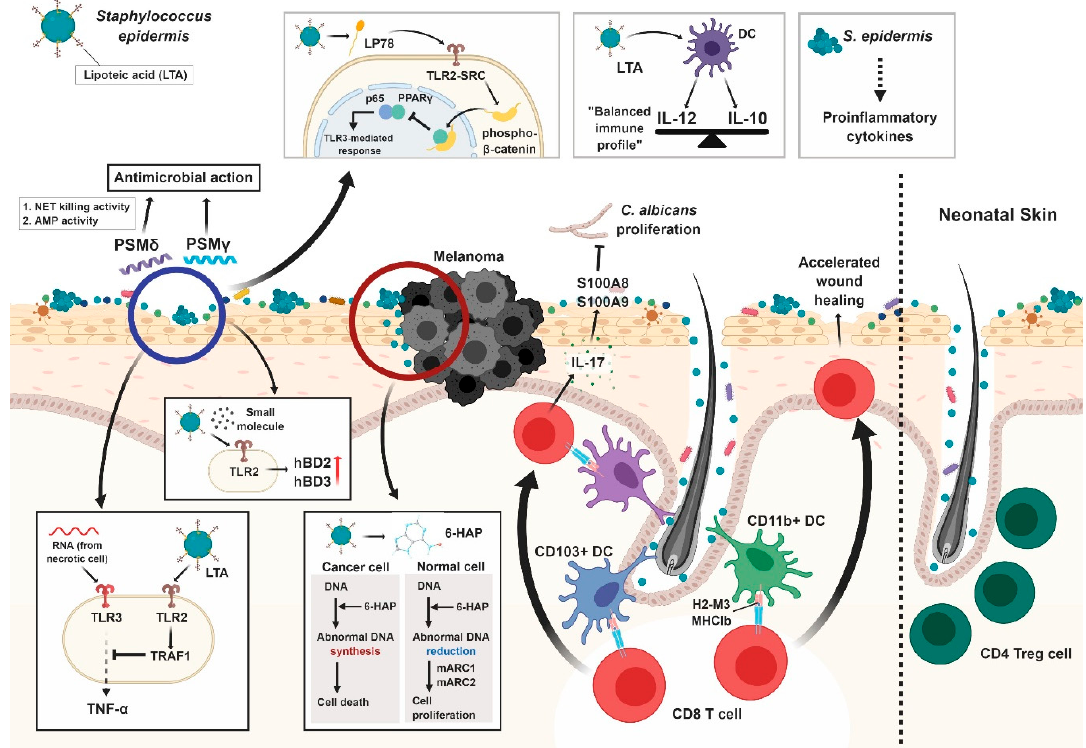
Figure 2. Interaction between Staphylococcus epidermis and skin immune system. When skin is injured, lipoteichoic acid (LTA) from the skin commensal S. epidermidis inhibits inflammatory cytokine production via inhibition of TLR3 signaling by TRAF1 activated through TLR2. S. epidermidis also produces small molecules that increase anti-microbacterial peptides through TLR2, which in turn inhibits pathogen growth. Lipopeptide 78 activates TLR2-SRC signaling in keratinocytes to induce β -catenin phosphorylation. Dissociation between p65 and PPAR γ due to phospho- β -catenin binding reduces TLR3-mediated inflammation. Phenol-soluble modulin γ (PSM γ ) and PSM δ from S. epidermidis also have anti-microbacterial activity. 6-HAP, a nucleobase analogue capable of selective tumor growth suppression was recently found to be produced by S. epidermidis . Cancer cells did not have sufficient mARC1 and mARC2 to reduce 6-HAP, leading to cell death. CD103+ dendritic cells (DCs) and CD11b+ DCs cooperate in tuning S. epidermidis -specific CD8+ T cells to protect from pathogen infection via upregulation of alarmins (S100A8 and S100A9). The commensal-specific CD8+ T cell response is induced by non-classical MHC class I molecules (H2-M3 MHCIb), and is immunoregulatory and tissue-repairing in nature. Dendritic cells (DCs) exposed to LTA preparations from S. epidermidis (epi-LTA) show an IL-10-balanced immune profile, with the ratio of IL-12p70 to IL-10 being close to 1; likewise, naïve CD4+ T cells primed by epi-LTA produce lower amounts of IFN- γ and IL-17. In neonatal skin, S. epidermidis is critical for the accumulation of CD4+ regulatory T cells, establishing tolerance to skin commensals. Even in low amounts, the inflammatory cytokines induced by S. epidermidis can lead to various consequences, such as sepsis, bronchopulmonary dysplasia, white matter injury, necrotizing enterocolitis, and retinopathy of prematurity. S. epidermidis also produces PSMs (PSM γ and PSM δ ), which directly induce lipid vesicle leakage and antimicrobial action against skin pathogens such as S. aureus [26]. PSMs reduce GAS selectively without affecting S. epidermidis growth. Finally, synthetic PSM δ not only binds to and increases the